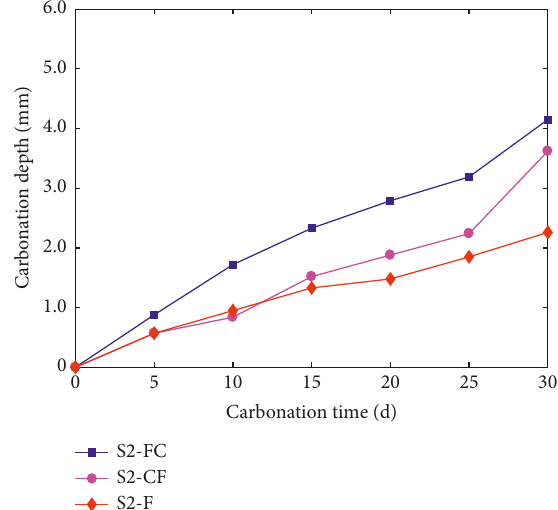
Figure 3: Damage difference of S2 between different testing modes.